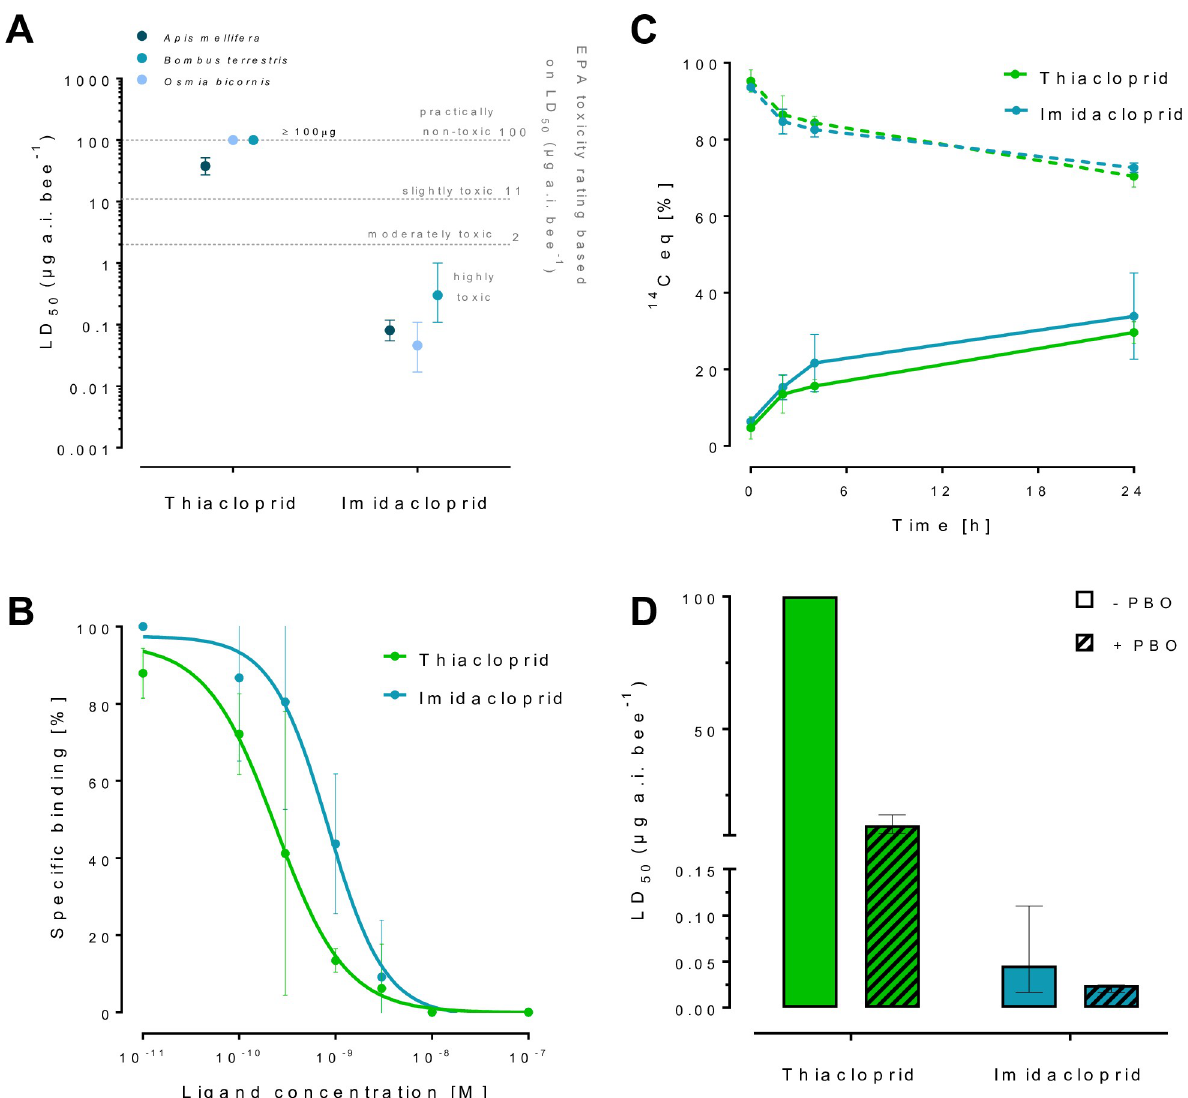
Fig 2. Toxicodynamics and pharmacokinetics of neonicotinoid sensitivity in O . bicornis . ( A ) LD 50 values for imidacloprid and thiacloprid in insecticide bioassays for O . bicornis , for comparison data is also shown for A . mellifera and B . terrestris . Sensitivity thresholds are depicted according to EPA toxicity ratings [45]. Data for A . mellifera is taken from [13,14],data for B . terrestris is taken from [3]. Error bars display 95% CLs (n = 4). ( B ) Specific binding of thiacloprid and imidacloprid to O . bicornis nAChRs. Error bars display standard deviation (n = 3). ( C ) Penetration of radiolabelled thiacloprid and imidacloprid through the cuticle of O . bicornis . The percentage of the initial 14 C-imidacloprid and 14 C-thiacloprid dose recovered by external cuticular rinsing over 24 hours is shown by dashed lines. The percentage of 14 C-imidacloprid and 14 C-thiacloprid recovered from combusted bees (i.e. internalized compound) is shown by solid lines. Error bars display standard deviation (n = 3). ( D ) Sensitivity of O . bicornis to imidacloprid and thiacloprid before and after pre-treatment with the insecticide synergist PBO (piperonyl butoxide). Error bars display 95% CLs (n =